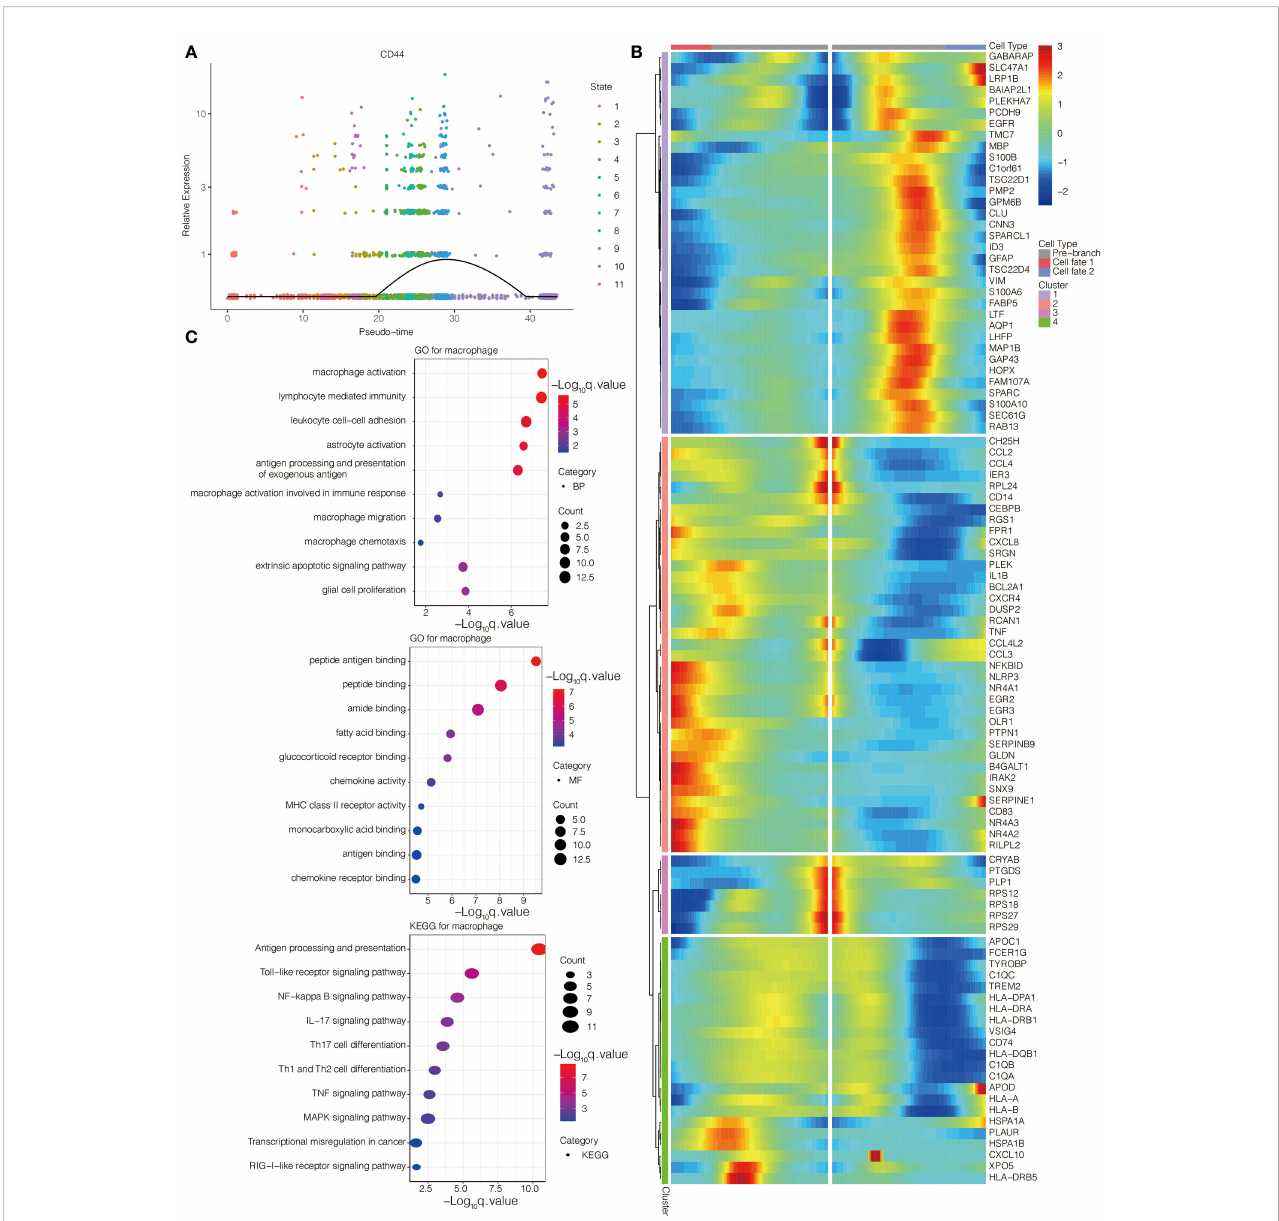
FIGURE 5 Function annotation of CD44 in macrophages at the scRNA-seq level. (A) The expression level of CD44 regarding the pseudotime and cell state changes. (B) The gene expression pattern of 100 genes with branch-dependent expression for branch point 3. (C) GO and KEGG enrichment